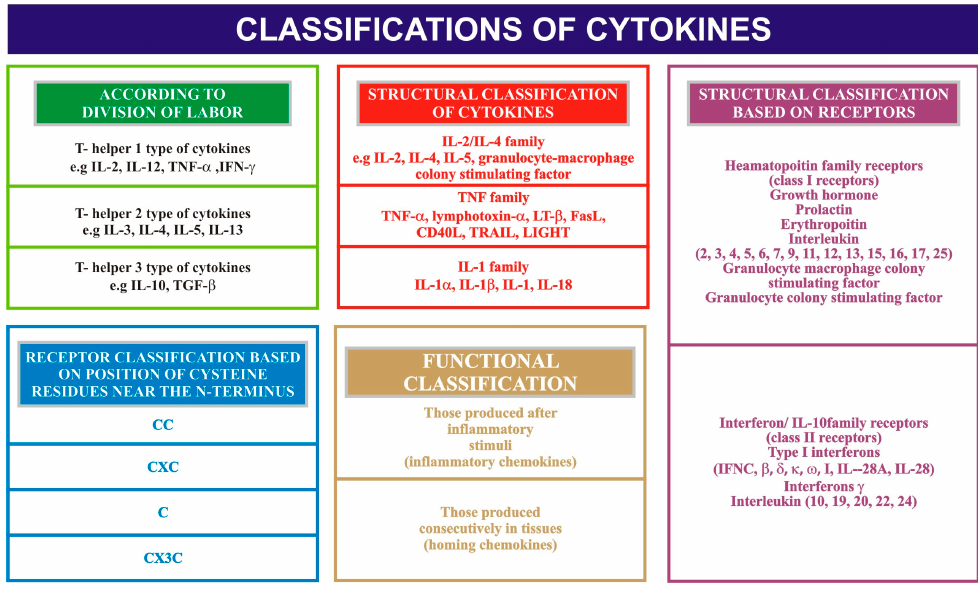
Classification of Figure 1. Classification of cytokines. IL = Interleukin; TNF = Tumor necrosis factor; IFN = Interferon; TGF = Transforming growth factor; TRAIL = TNF-related apoptosis inducing ligand;